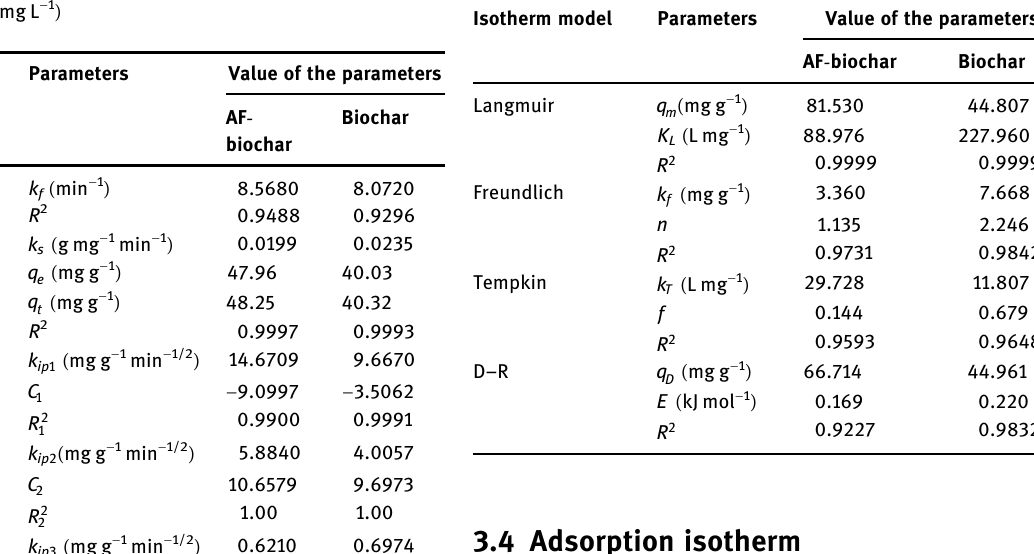
Table 3: Parameters of Langmuir, Freundlich, Tempkin, and D – R ( conditions: T = 25°C; pH 4.6; duration = 85 min